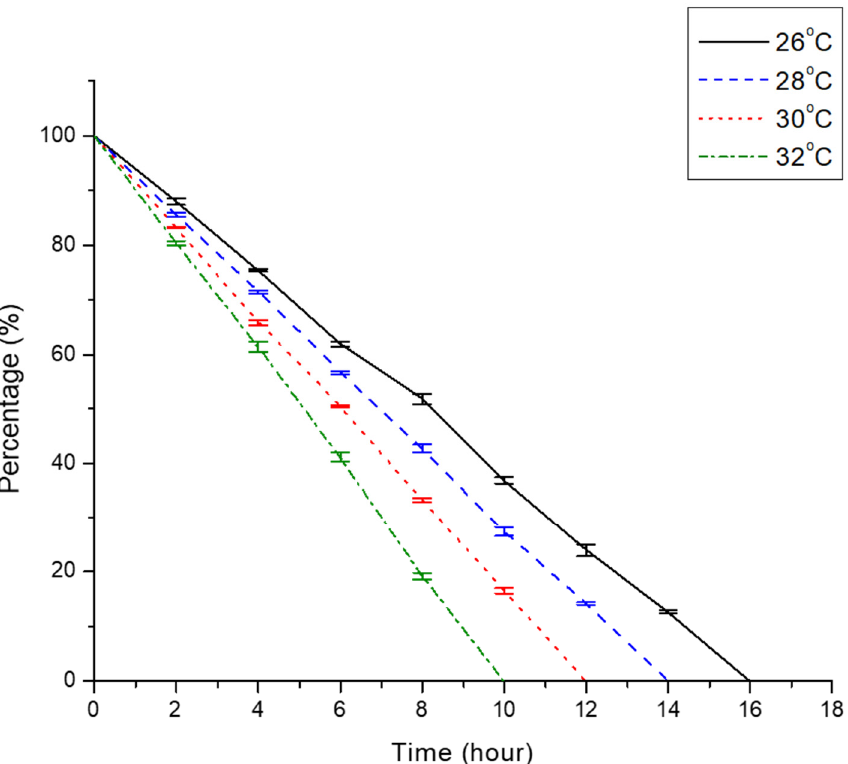
Figure 1. Percentage of feed retention in fish digestive system at an interval of two hours for each experimental group (26, 28, 30, and 32 °C). Error bars represent the SE of mean percentage values of five fish ( n = 5) which were analysed at each time point.